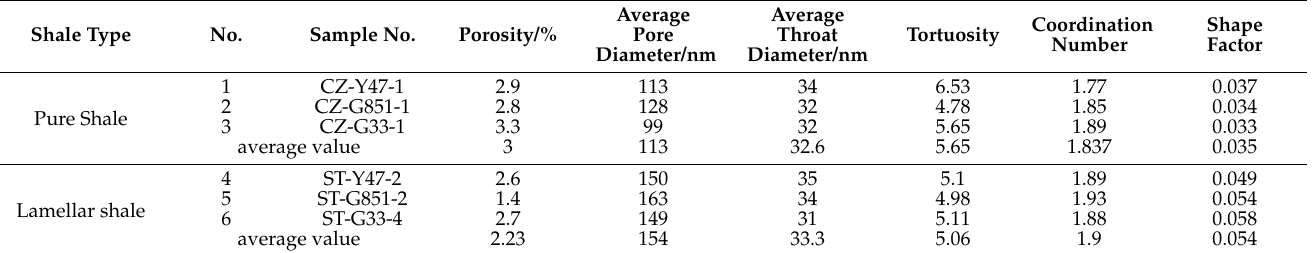
Figure 8. Average throat diameter in different directions of CZ-Y47-1. Table 3. Summary of pore and throat structure parameters.